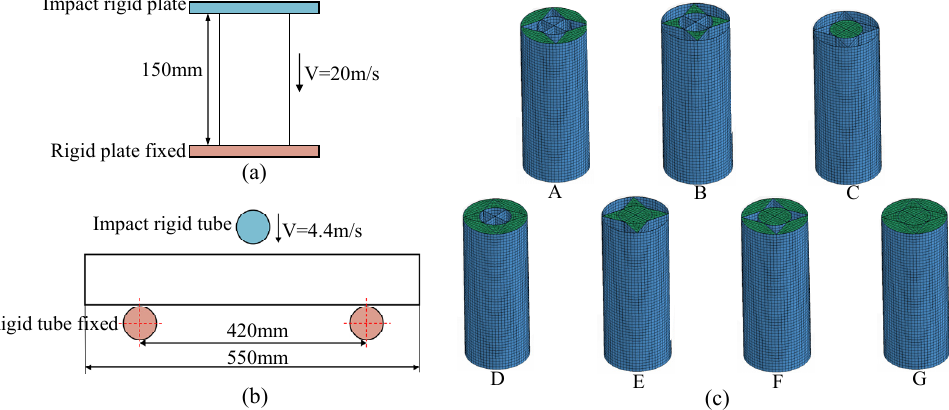
Figure 2. Finite element model of the filled structure. ( a ) the calculation model of the axial compression; ( b ) the calculation model of the axial compression; ( c ) Finite element mesh model of thin-walled tube.